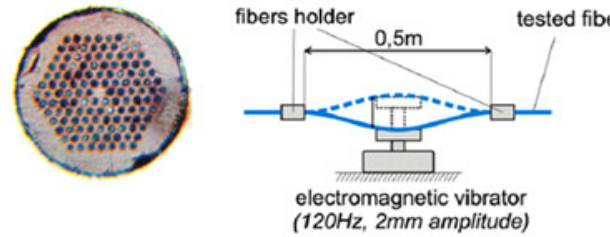
Figure 32. Cross-section of tested PCF and set up to measure current using electromagnetic vibration (Reproduced from [99], with the permission of author).